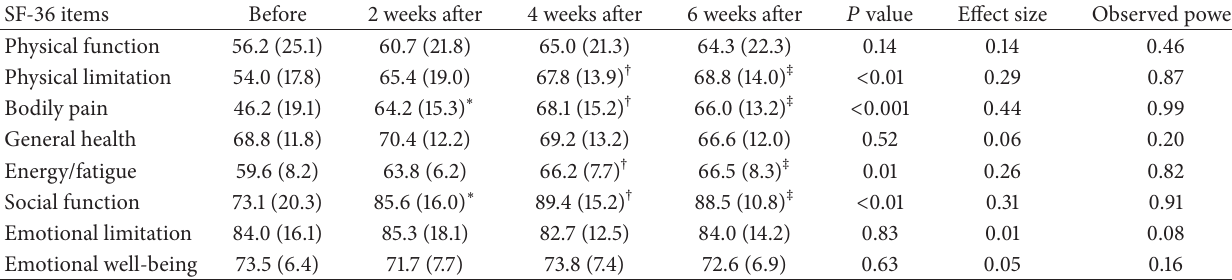
Table 1: SF-36 scores (%) before and after injection: Means (SD).